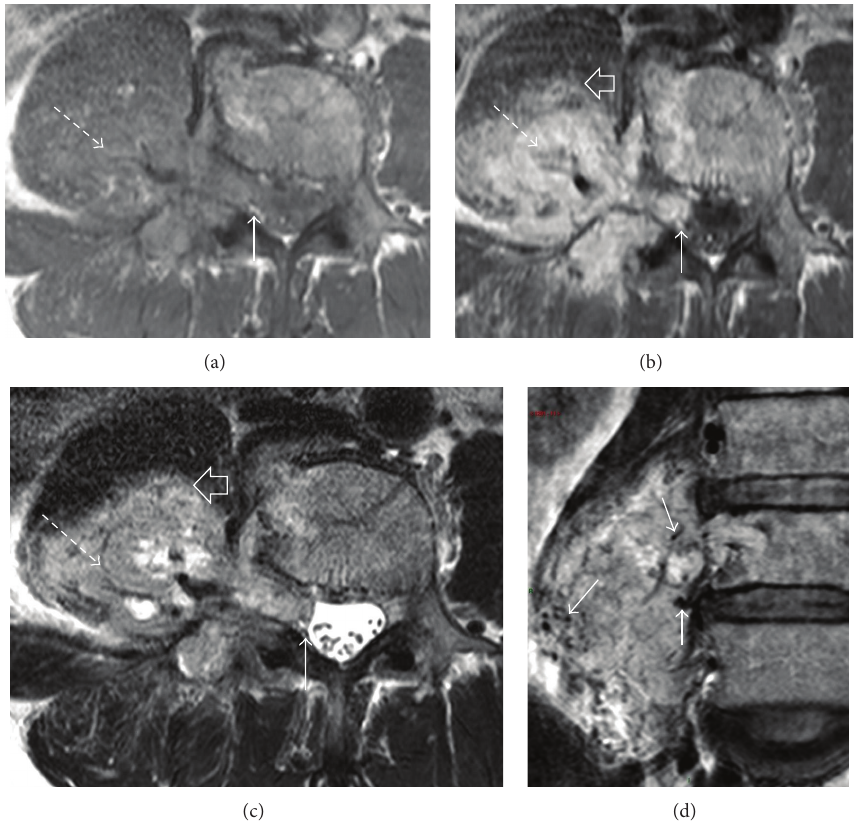
Figure4:MRIatL4lumbarlevelwithaxialT1W(a),T1Waftercontrast(b),andT2W(c)showsaT1-hypointense,T2-heterogenousparaspinal tumour with avid enhancement (dashed arrow). It extends into the moderately widened neural foramen with central displacement of the thecal sac (arrow). The tumour infiltrates the psoas muscle (open arrow). Coronal T2-weighted image (d) demonstrates hypointense tubular structures within the tumour (arrows) compatible with flow voids, indicative of hypervascularity.